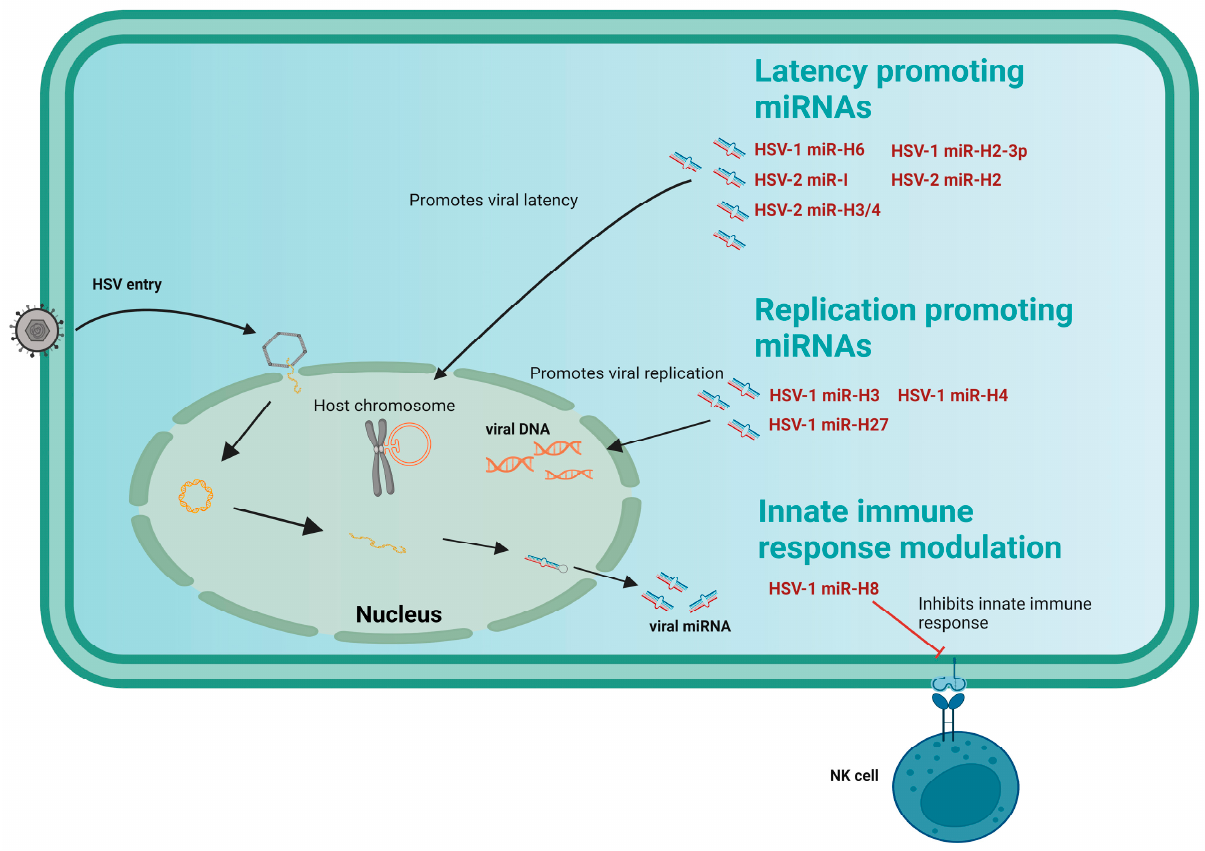
Figure 2. HSV miRNA: A schematic representation of reported miRNAs produced by human simplex virus HSV-1, and HSV-2 to modulate the host immune response by deregulating the pro/antiviral functions, triggering viral replication, and promoting long-term latency by integration/maintaining the viral genome into the host chromosome.